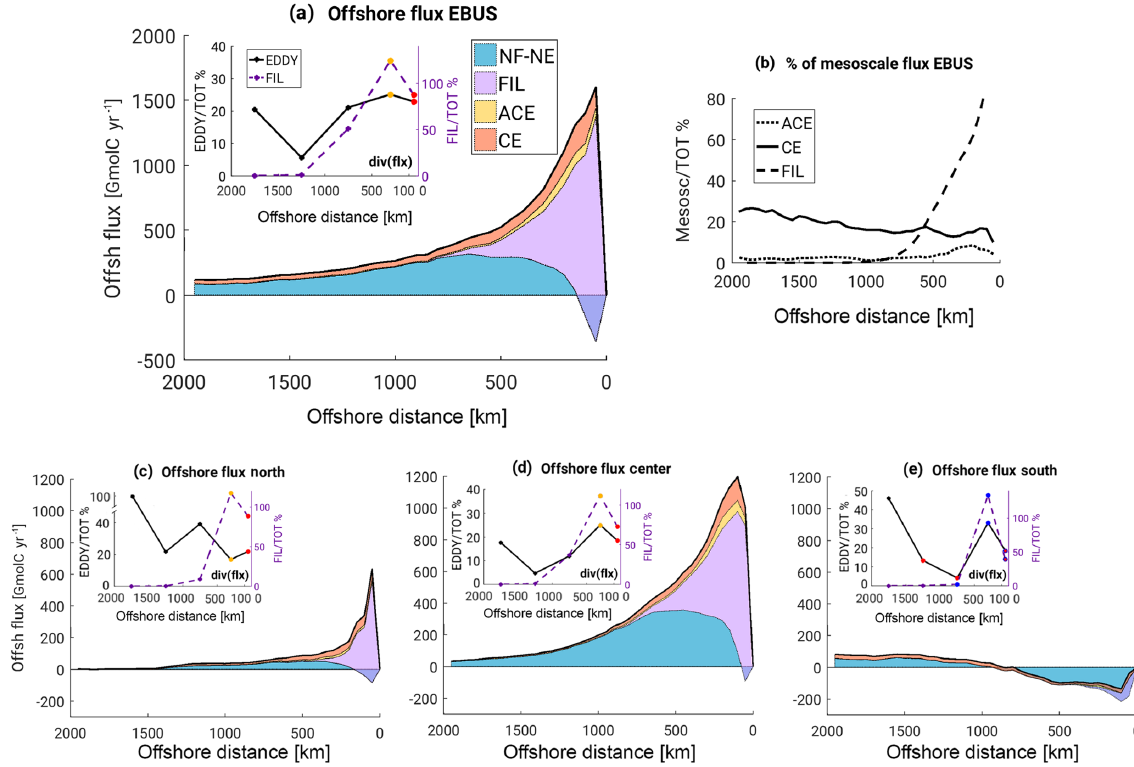
Figure 12. Magnitude of the non-filament–non-eddy (NF-NE), filament (FIL), anticyclonic (ACE), cyclonic (CE) components of the offshore flux [GmolCyr − 1 ]: (a) Canary EBUS as a whole; (c) northern CanUS; (d) central CanUS; (e) southern CanUS. In all area plots: the black thick line is the total offshore flux, sum of the four components; fluxes are integrated in the first 100m depth. The purple area shading results from the overlapping of opposing NF-NE and filament flux contributions. (b) only for the full EBUS we show the ratio of the magnitude of the mesoscale/total offshore flux for FIL, ACE and CE. Inserts: ratio between the absolute value of the divergence of the filament or eddy (ACE + CE) component and that of the total flux within the 100m. Per each offshore range, divergences are calculated as finite differences at the boundaries shown on the x axis. Dots are red when total and mesoscale divergences are negative (fluxes remove C org ); dots are yellow if only the NF-NE divergence is negative; dots have the same color of the line when all divergences are positive (fluxes add C org ). For the southern subregion only: blue dots indicate that the total flux divergence is negative and opposes the mesoscale flux divergence; dots are red with a blue edge when the opposite is